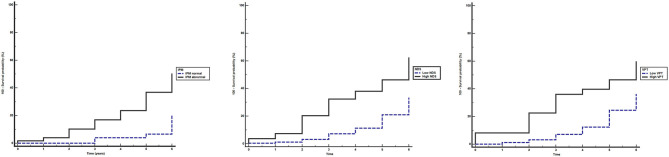
Kaplan–Meier estimates of foot ulceration in participants during the study period. Equality of the survivor functions between the groups stratified by different neurological modalities was performed using the log-rank test. (A) abnormal (continuous line) vs. normal (dashed line) indicator plaster method (IPM) (A): X2 = 18.364, p < 0.001; (B) high (≥6) (continuous line) vs. low (<6) (dashed line) neuropathy disability score (NDS): X2 = 20.291, p < 0.001; (C) high (≥25) (continuous line) vs. low (<25) (dashed line) vibration perception threshold (VPT) (Volts): X2 = 14.079, p < 0.001.